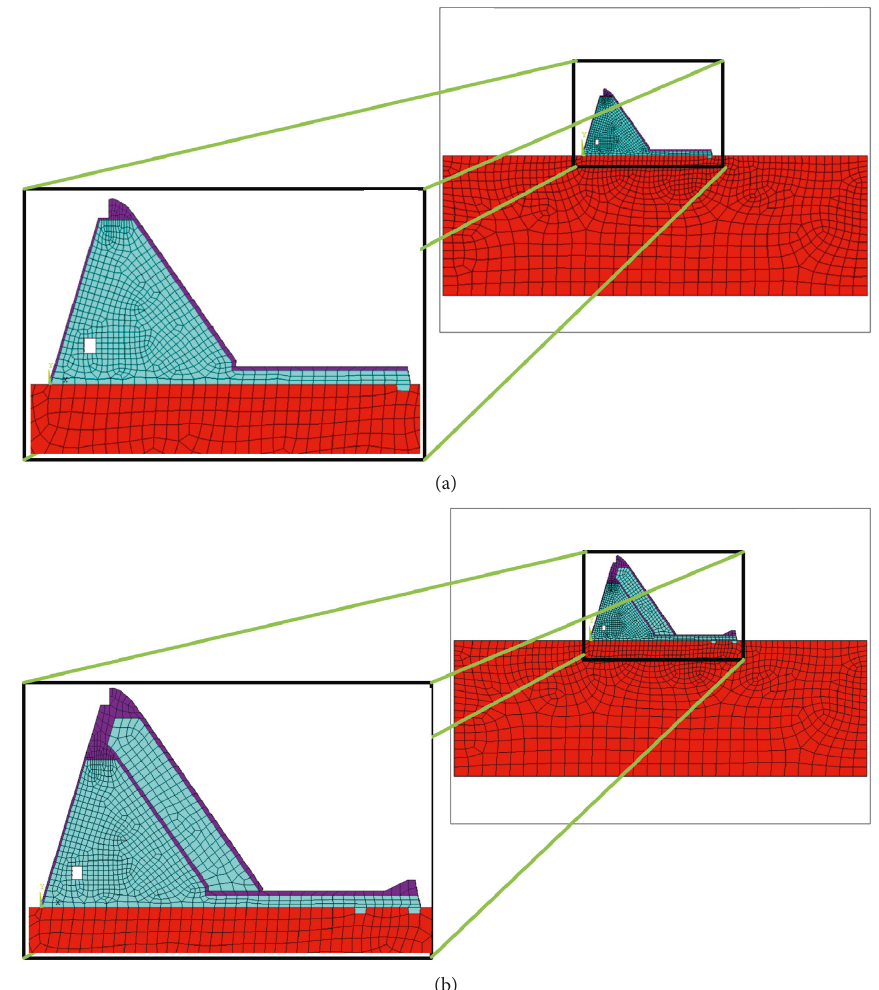
Figure 7: Finite element mesh of RCC section: (a) initial section and (b) final